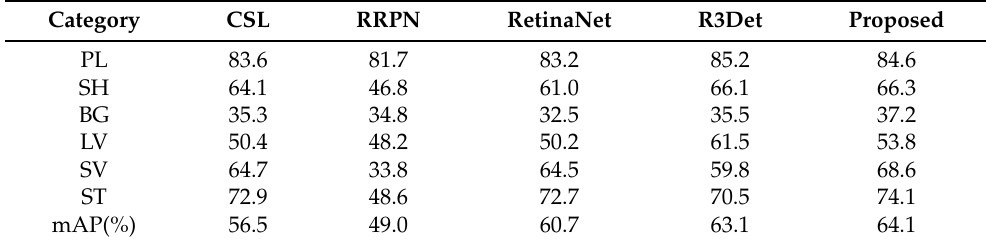
Table 5. Comparison results of different algorithms on the DOTA-GF dataset.